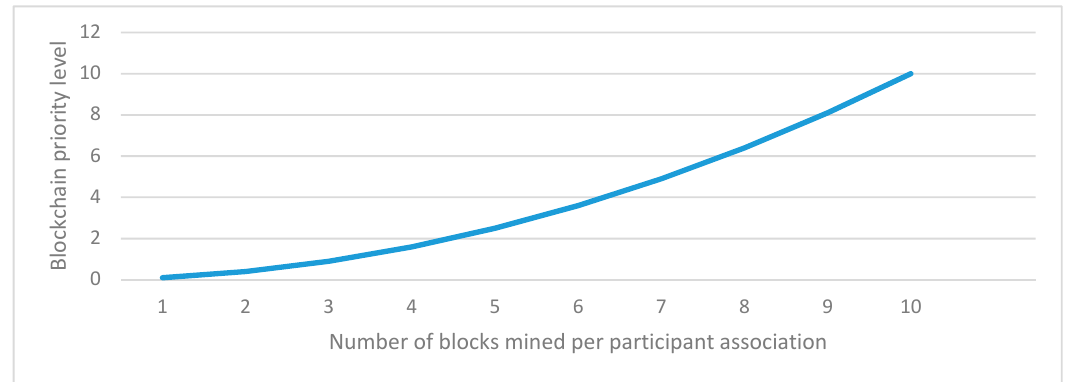
Figure 29. Comparative analysis of blockchain priority level and number of blocks mined per Figure29. participant.